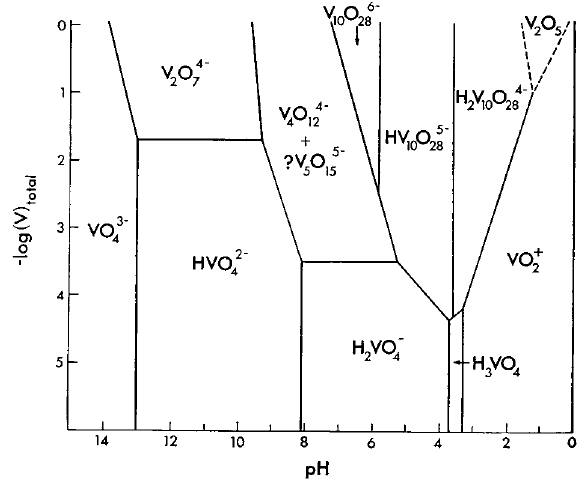
Figure 1 Speciation diagram showing the oxidation state and major species of vanadium as a function of pH and reduction